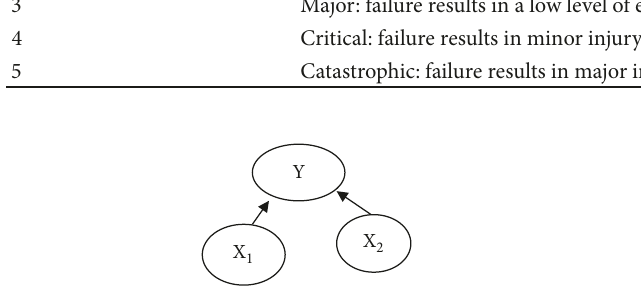
Figure 1: Bayes net with two independent variables.